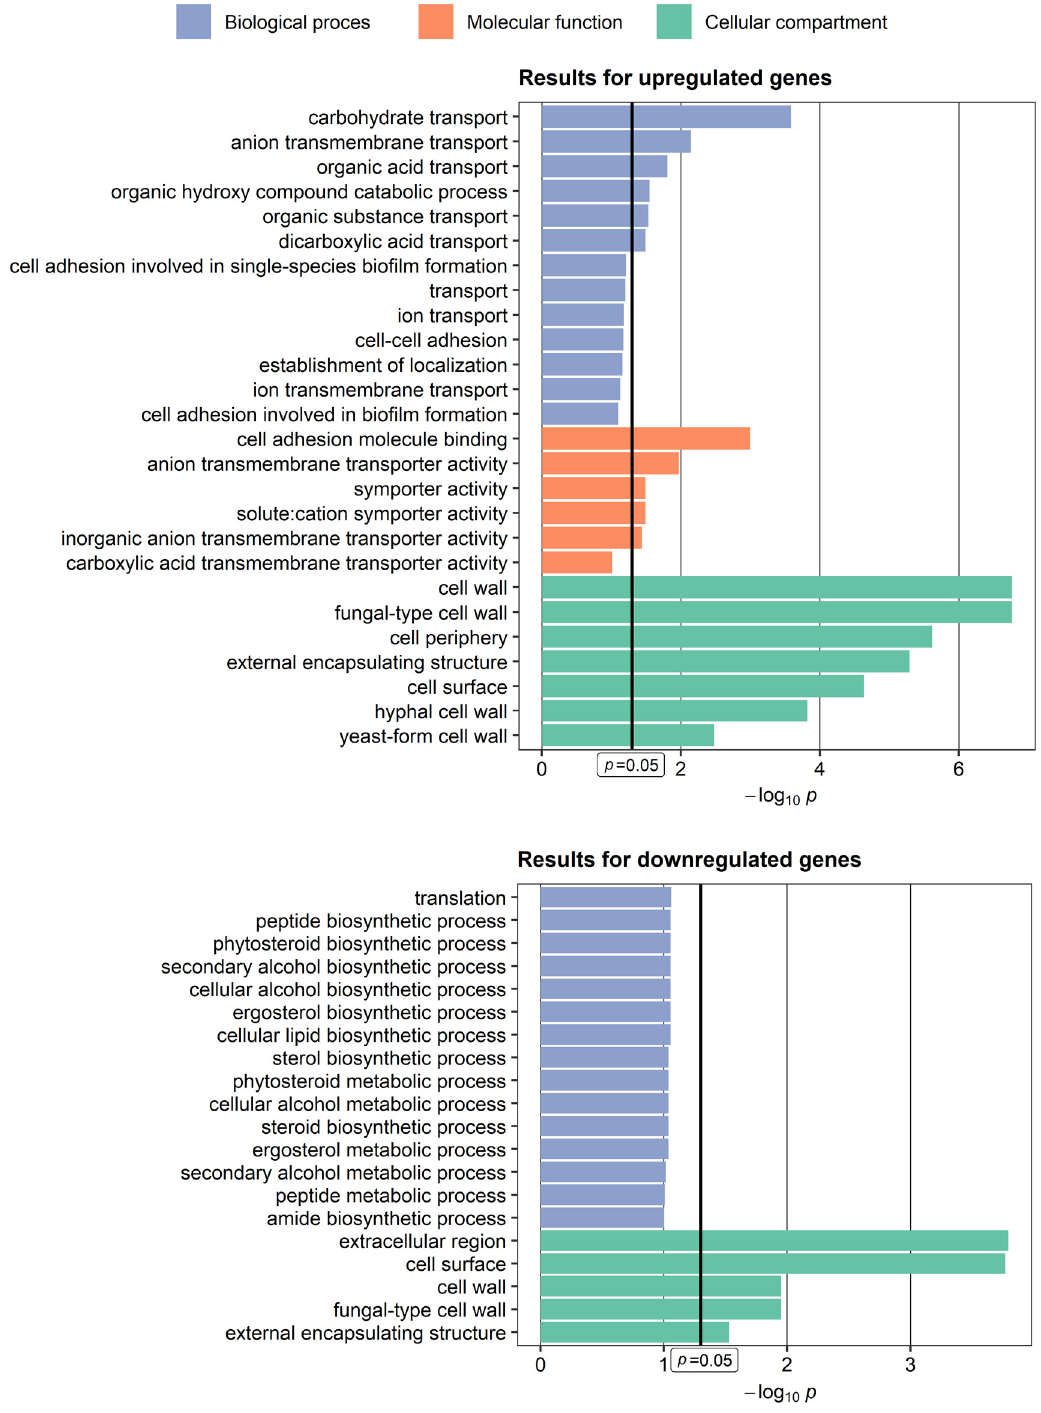
Figure 4. Results of Gene Ontology functional analysis performed for up- and downregulated genes selected in this study.